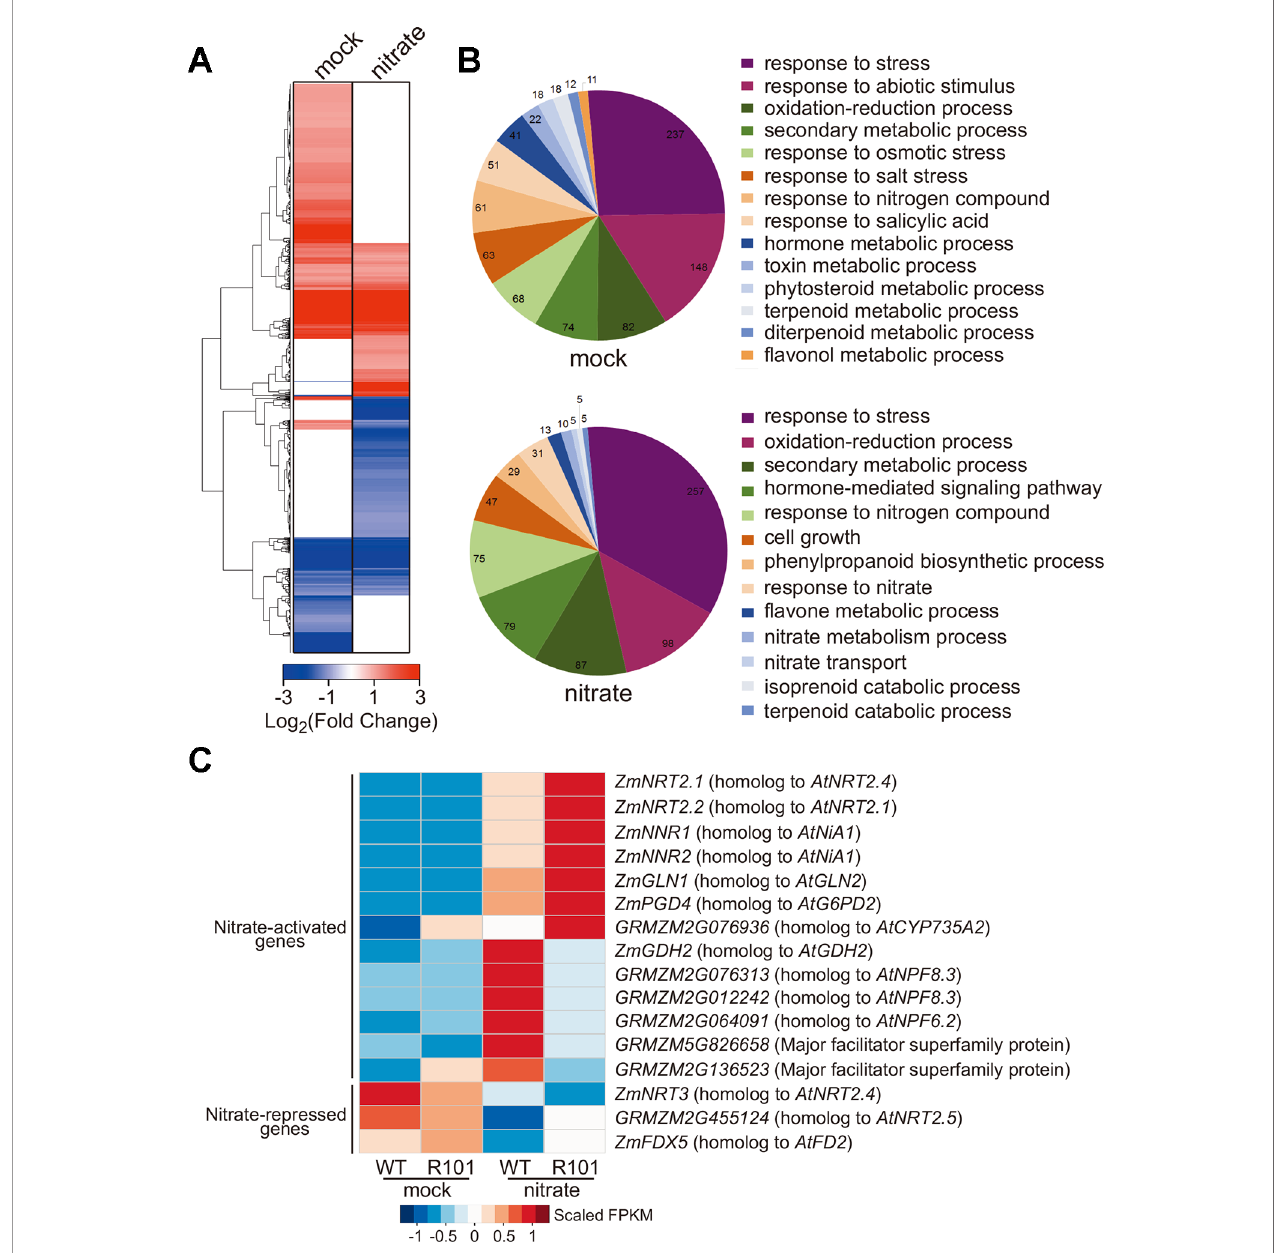
FIGURE 3 | ZmCHB101 regulates transcriptional networks of nitrate-responsive genes in maize roots. (A , B) Hierarchical clustering analysis (A) and Gene Ontology (GO) enrichment analysis (B) of genes differentially expressed between 7-day-old nitrate-free WT and ZmCHB101-RNAi line R101 seedlings under the mock and nitrate condition. A total of 862 and 786 differentially expressed genes (DEGs) were identi fi ed in the WT vs. R101 comparison under the mock and nitrate condition, respectively. The pie charts in (B) show signi fi cantly enriched GO terms of DEGs. (C) Heatmap of DEGs involved in nitrate metabolism. The color scale indicates the FPKM values. Mock, nitrate treatment for 0 h; nitrate, nitrate treatment for 2